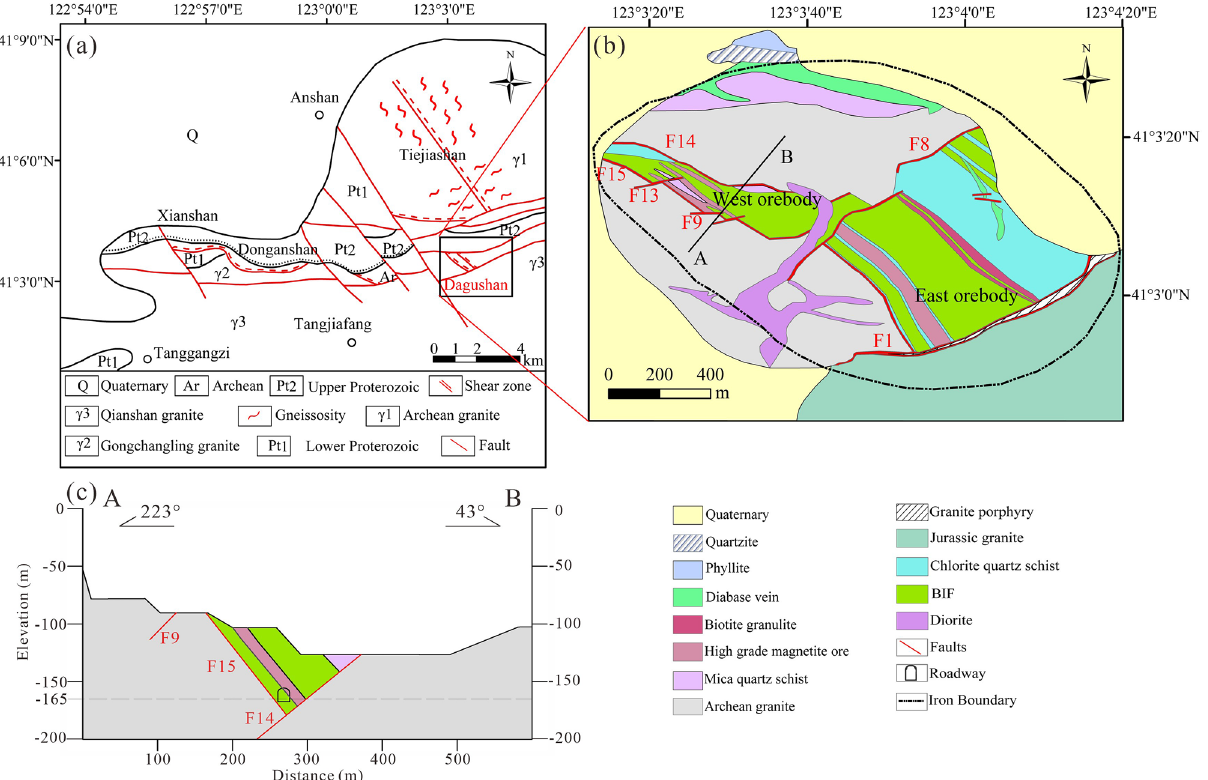
Figure 1. Geological setting of the study area. (a) Geological structure sketch map of the Anshan area (modified from 41–43 ). (b) Geological structure of the mine area. (c) Geological section of the